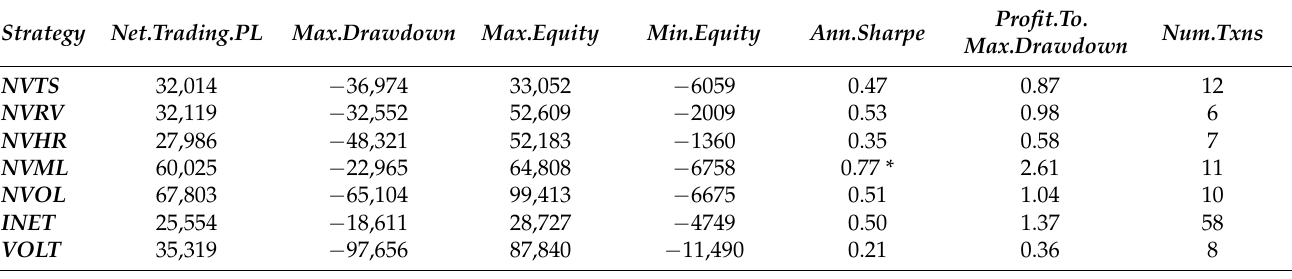
Table 6. Selected comparison of trading strategies: 10 December 2017/30 March 2022 . Strategy